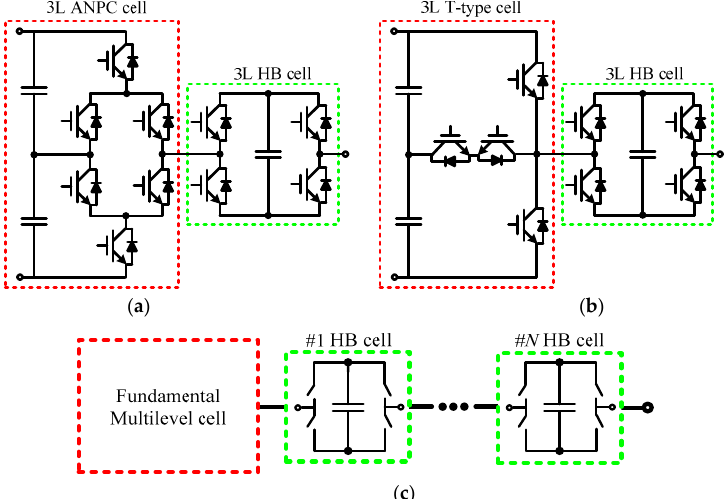
Figure 11. Hybrid cascaded HB converters ( a ) based on 3L ANPC cell [35], ( b ) based on 3L T-type cell [36], ( c ) general structure with N HB cells.